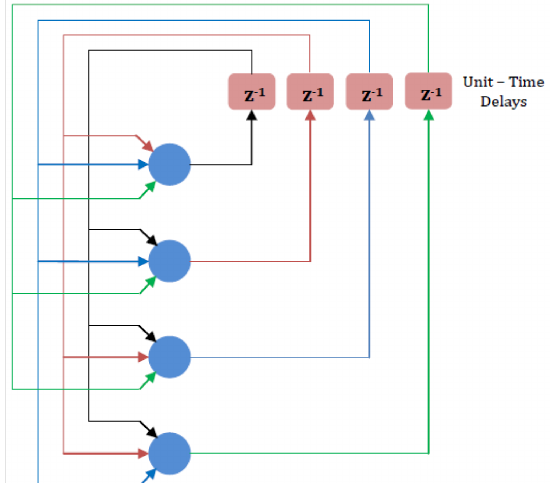
Figure 6. Simple recurrent network structure with one layer with feedback from output to the inputs and without